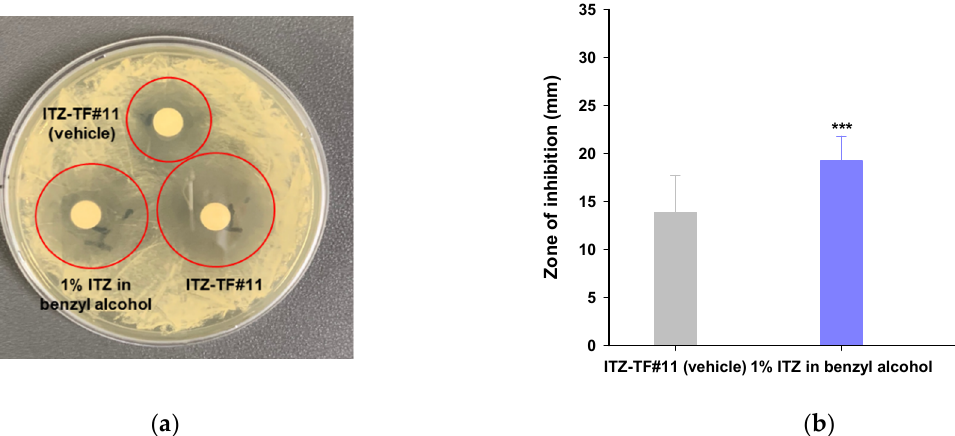
Figure 2. In vitro antifungal efficacies of ITZ–TF#11 (vehicle), 1% ITZ in benzyl alcohol, and ITZ–TF#11. ( a ) Image depicting zones of inhibition of C. albicans in a Petri dish. ( b ) Zone of inhibition (mm). Each value represents the mean ± standard deviation ( n = 4). *** p < 0.001 compared with ITZ–TF#11 (vehicle). ## p < 0.01 compared with 1% ITZ in benzyl alcohol. Table 4. Minimum inhibitory concentration (MIC) and minimum fungicidal concentration (MFC)